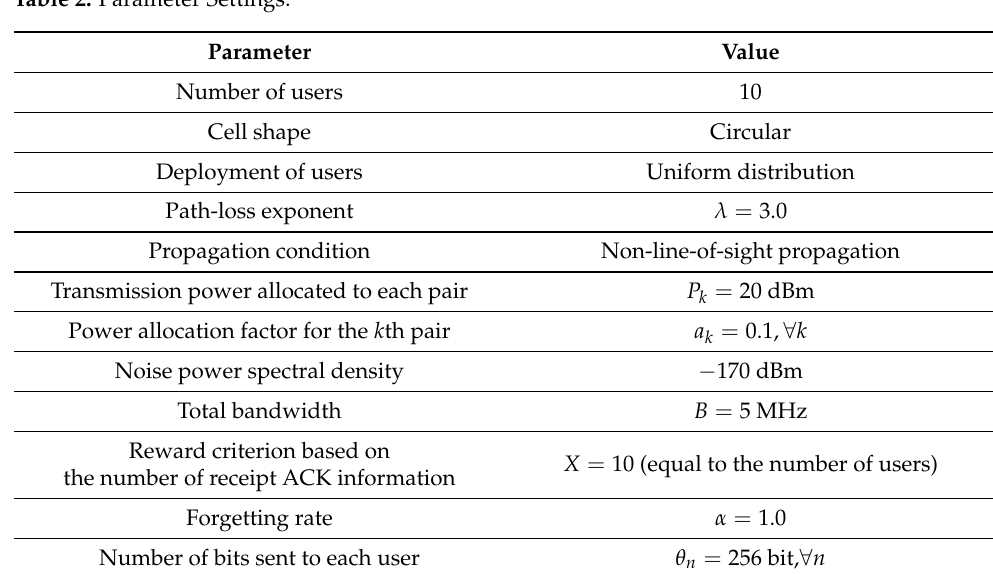
Table 2. Parameter